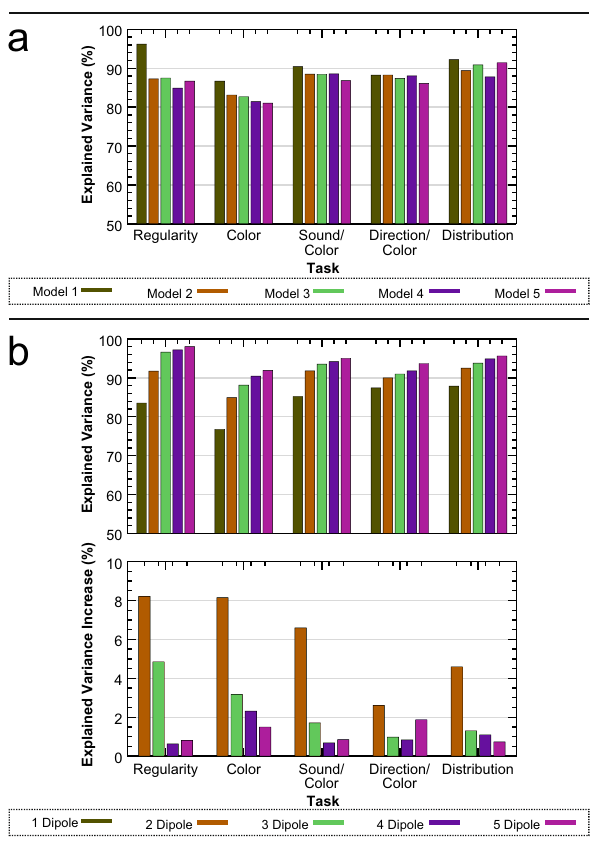
Figure 5. Source dipole model sufficiency testing. ( a ) Explained variance for the final five models fitted to the data from each task individually. ( b ) Explained variance for a new set of source dipole models comprising between 1 and 5 dipoles for each task. Total explained variance is shown (top) as well as an increase in explained variance from a dipole model comprising one less dipole